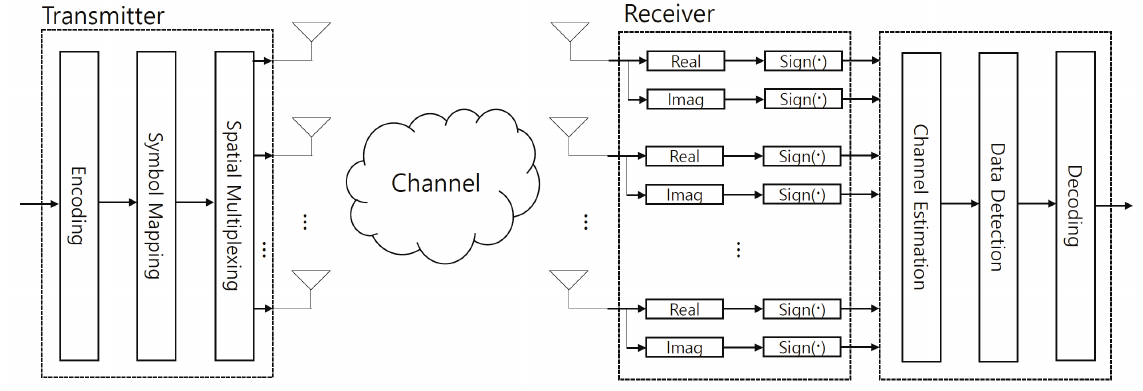
Figure 1. Transmitter and receiver for MIMO systems using one-bit